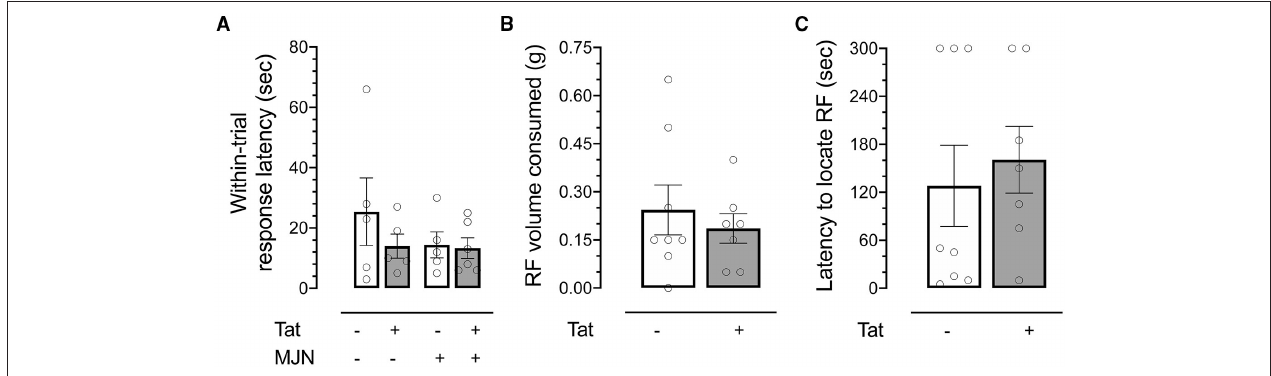
FIGURE 4 | (A) No significant differences were observed between groups in response latency within reversal trials. (B) No significant differences in volume of reinforcer consumed were observed between genotypes. (C) No significant differences were observed between Tat( + ) and Tat(–) subjects in latency to locate a hidden reinforcer. Data are mean ± SEM. Statistical significance was determined using ANOVA and Bonferroni correction where applicable. An alpha level of p < 0.05 was considered significant for all statistical tests. RF, reinforcer.